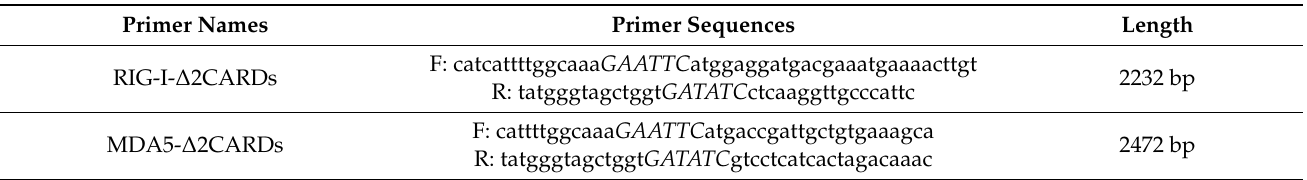
Table 1. The PCR primer sequences for cloning of porcine RIG-I- ∆ 2CARDs and MDA5- ∆ 2CARDs. Primer